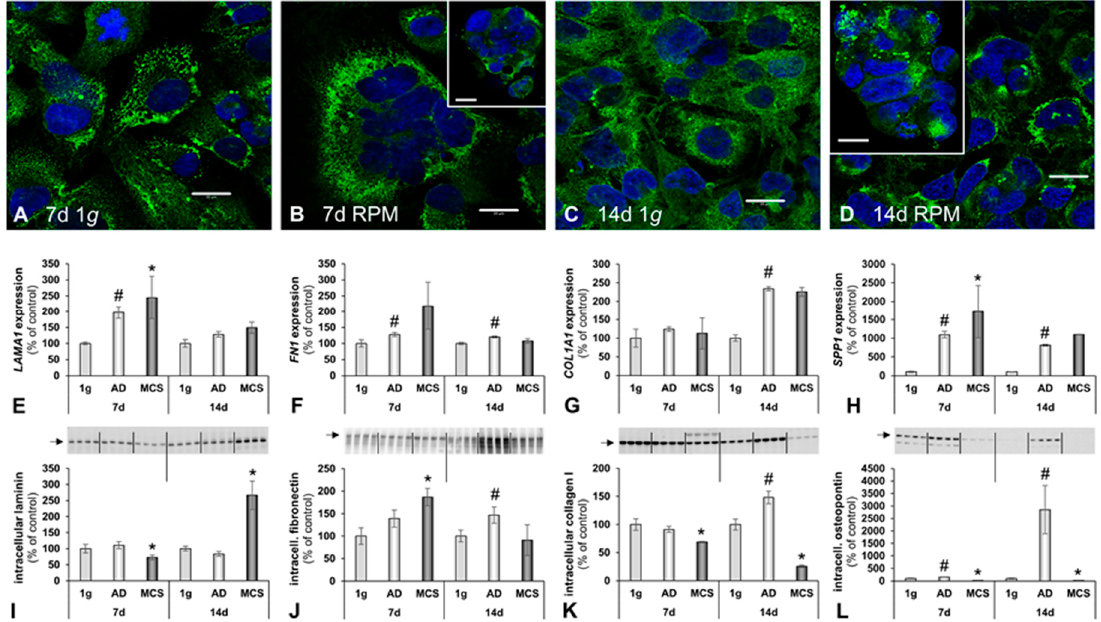
Figure 4. The influence of simulated microgravity on the extracellular matrix (ECM) of human osteoblasts. Laminin immunofluorescence. ( A ) 7 days 1 g control cells, ( B ) 7 days RPM exposed cells, ( C ) 14 days 1 g control cells and ( D ) 14 days RPM exposed cells. Gene expression of selected ECM genes: ( E ) Laminin α 1 ( LAMA1 ); ( F ) fibronectin ( FN1 ); ( G ) collagen I subunit α 1 ( COL1A1 ); and ( H ) osteopontin ( SPP1 ). Intracellular ECM protein levels: ( I ) Laminin; ( J ) fibronectin; ( K ) collagen type I; and ( L ) osteopontin. All values are given as mean ± standard deviation. # p < 0.05 1 g vs. AD; * p < 0.05 1 g vs. MCS. Scale bars: 20 μ m, d, days.